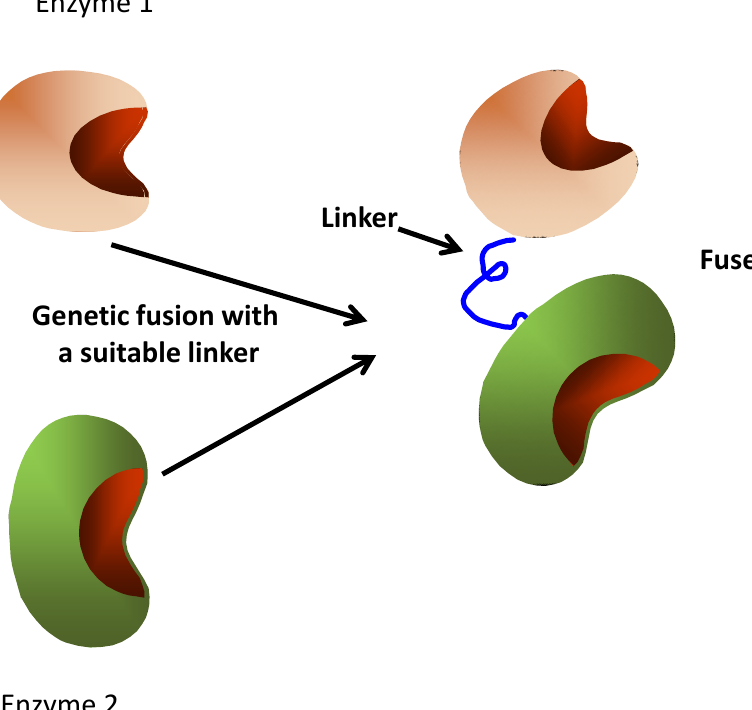
Figure 2. Design of artificially fused